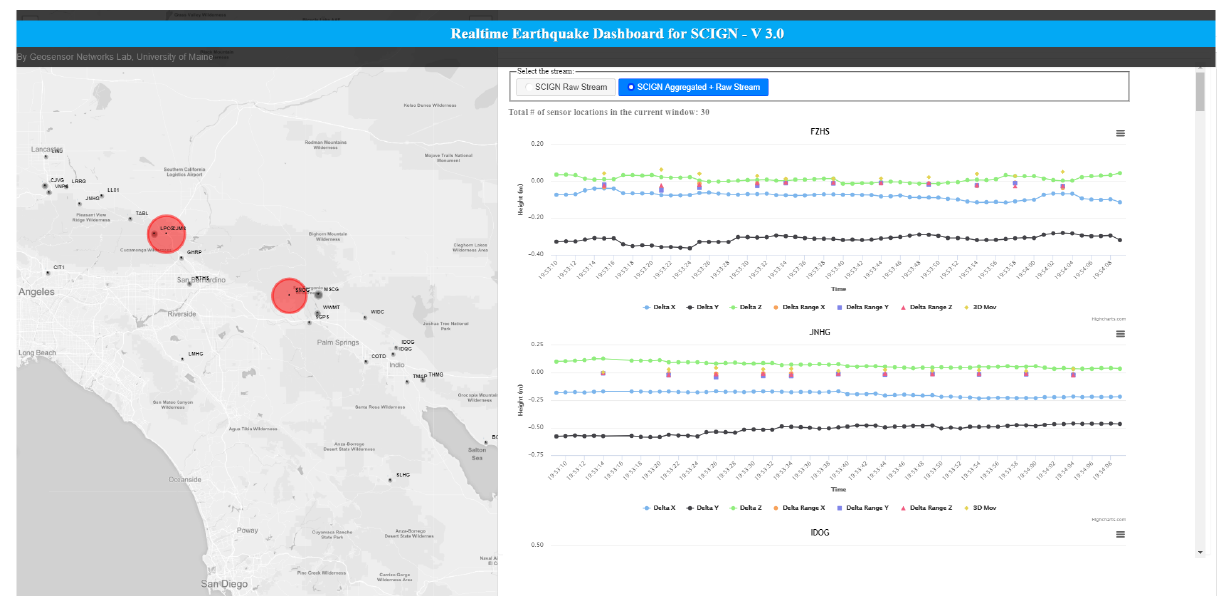
Figure 4. Web Visualization Client Dashboard with Spatial Visualization and Live